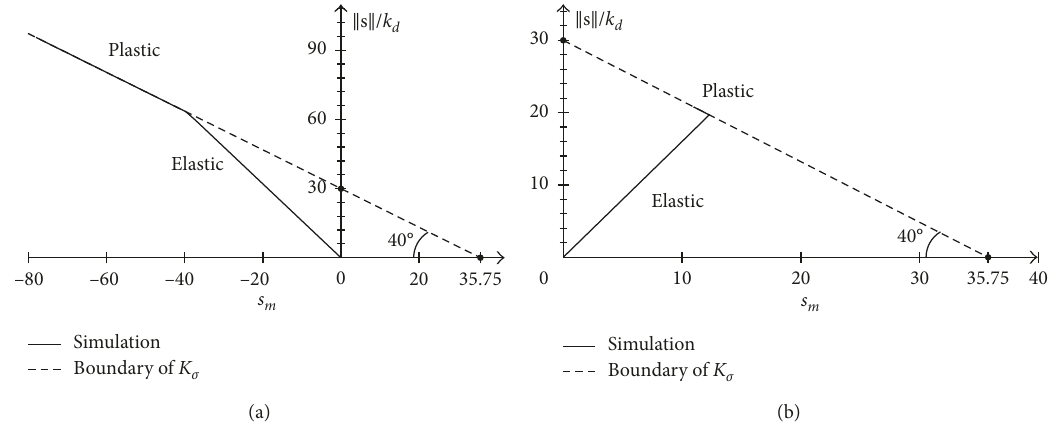
Figure 5: Comparison of the simulated constitutive law versus the theoretical one: (a) compression; (b) tension.